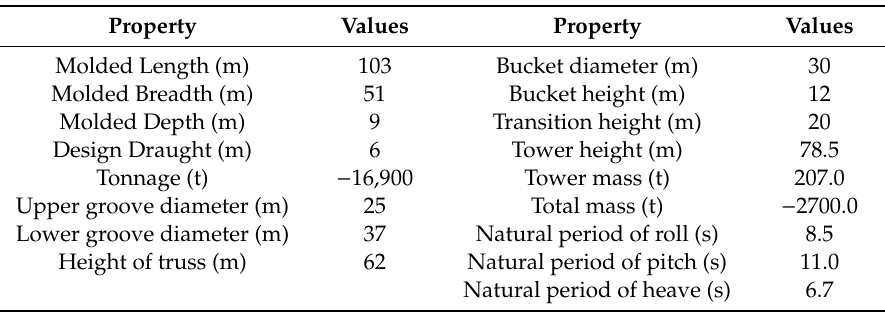
Table 1. The parameters of the overall structure.